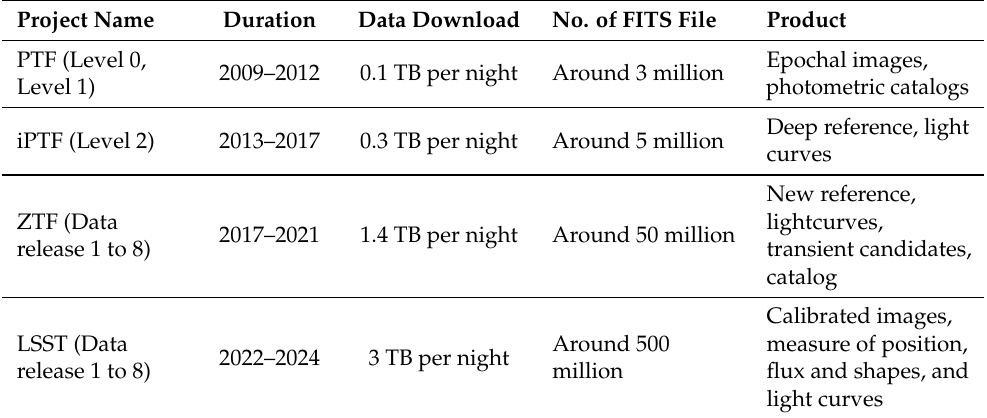
Table 1. ZTF science data